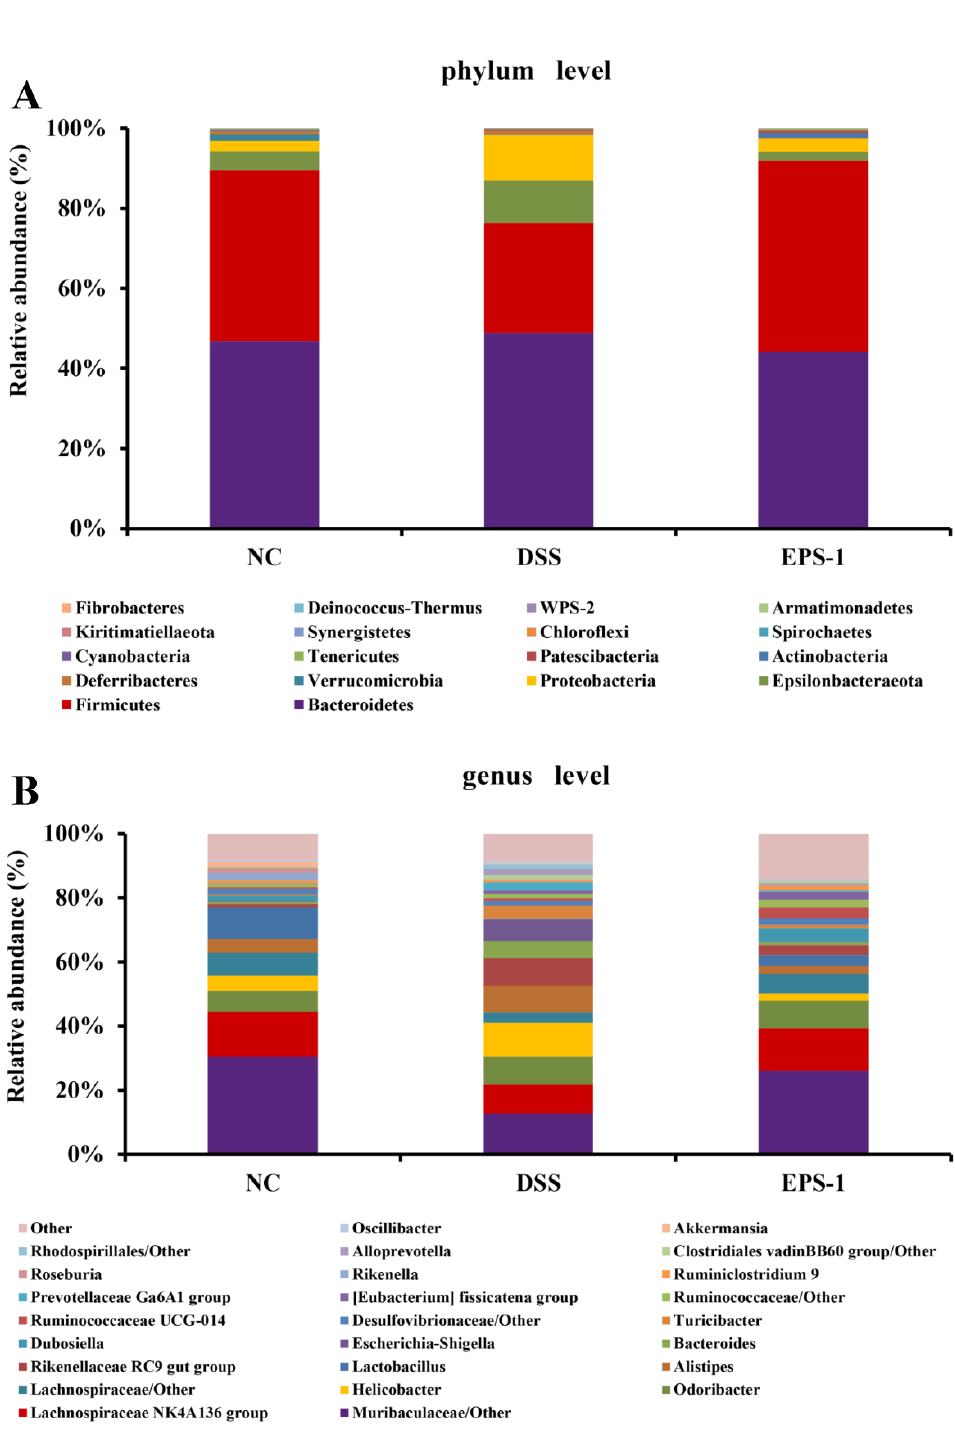
Figure 5. Relative abundance of microbial species at the phylum level ( A ), genus levels ( B ) in the feces of mice.